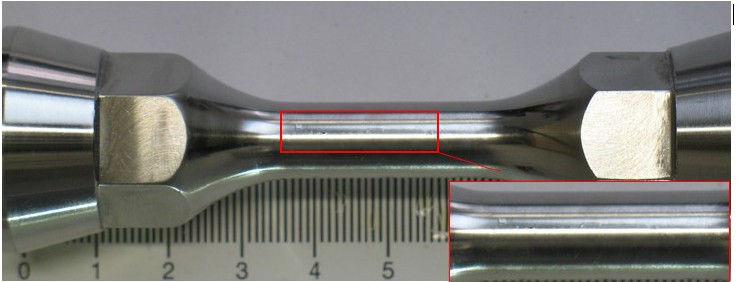
Figure 8. Specimen after 350,000 cycles at 250 MPa and max. torsional angle of 7.5 ◦ . Test section appears shiny and fine cracks parallel to longitudinal axis are present (though not very